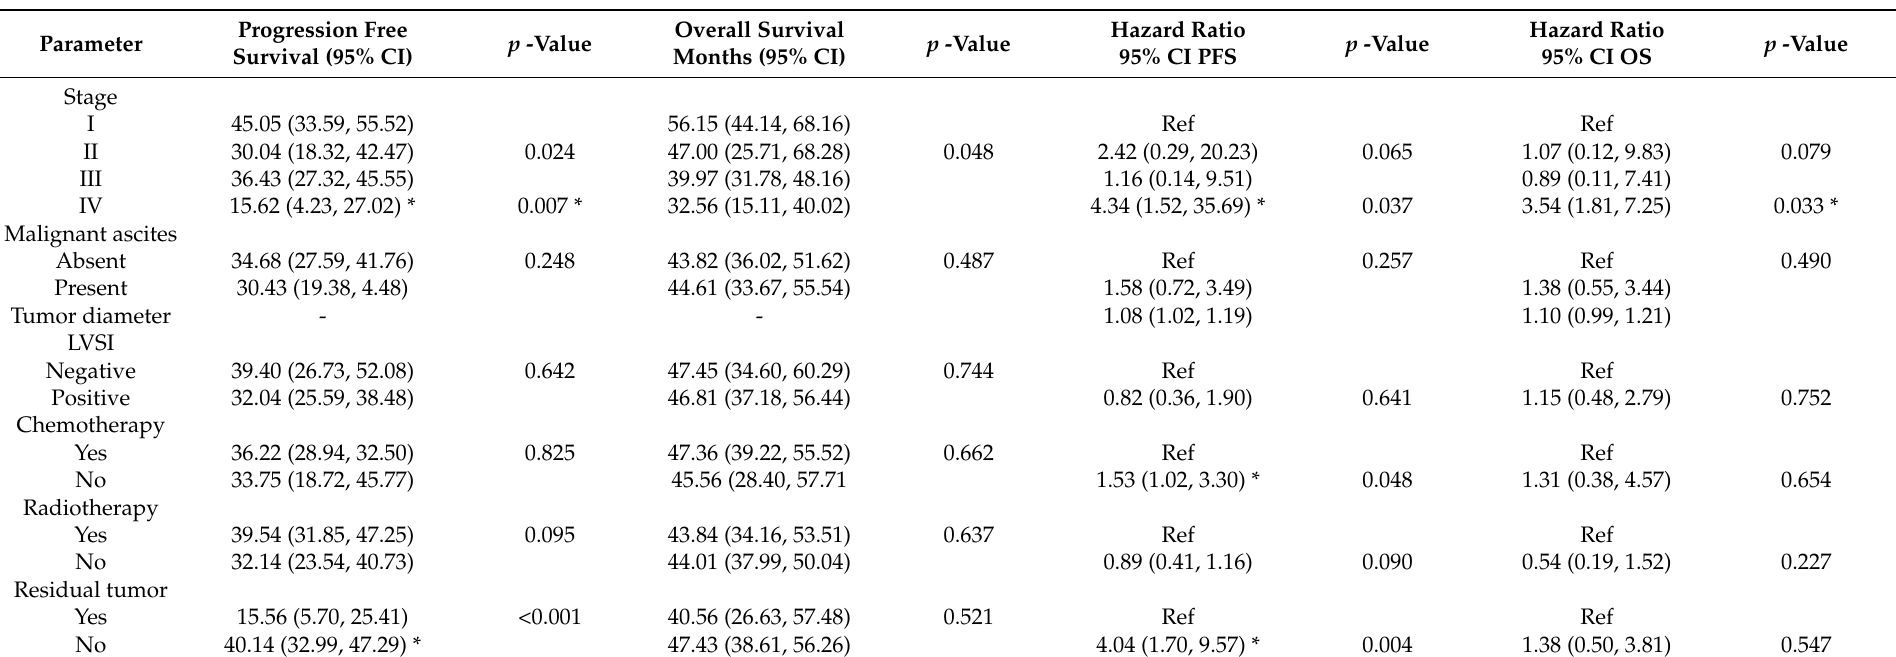
Table 2. Survival outcomes among selected subgroups of patients. Survival outcomes according to the stage of the disease, tumor diameter, presence of lymphovascular space involvement (LVSI), use of chemotherapy or radiotherapy and residual tumor following